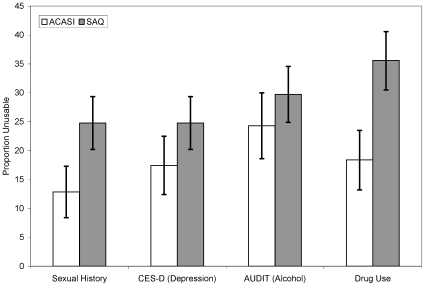
Proportion of unusable data from the survey by threshold for unusable data and section of the questionnaire.Unusable data was defined as having responded to less than 75% of the questions for the selected domains of the survey. The dark gray bars represent participants who chose SAQ, while the white bars represent participants who chose the ACASI version of the survey. Error bars in Figure 1 represent the 95% confidence interval. 95% confidence intervals that do not overlap imply a statistical difference in unusable data by survey modality for that particular domain. CES-D: Center for Epidemiologic Studies Depression Scale. AUDIT: Alcohol Use Disorders Identification. STD: Sexually Transmitted Disease. ACASI: Audio Computer Assisted Self-Interview. SAQ: Self-Administered Questionnaire.